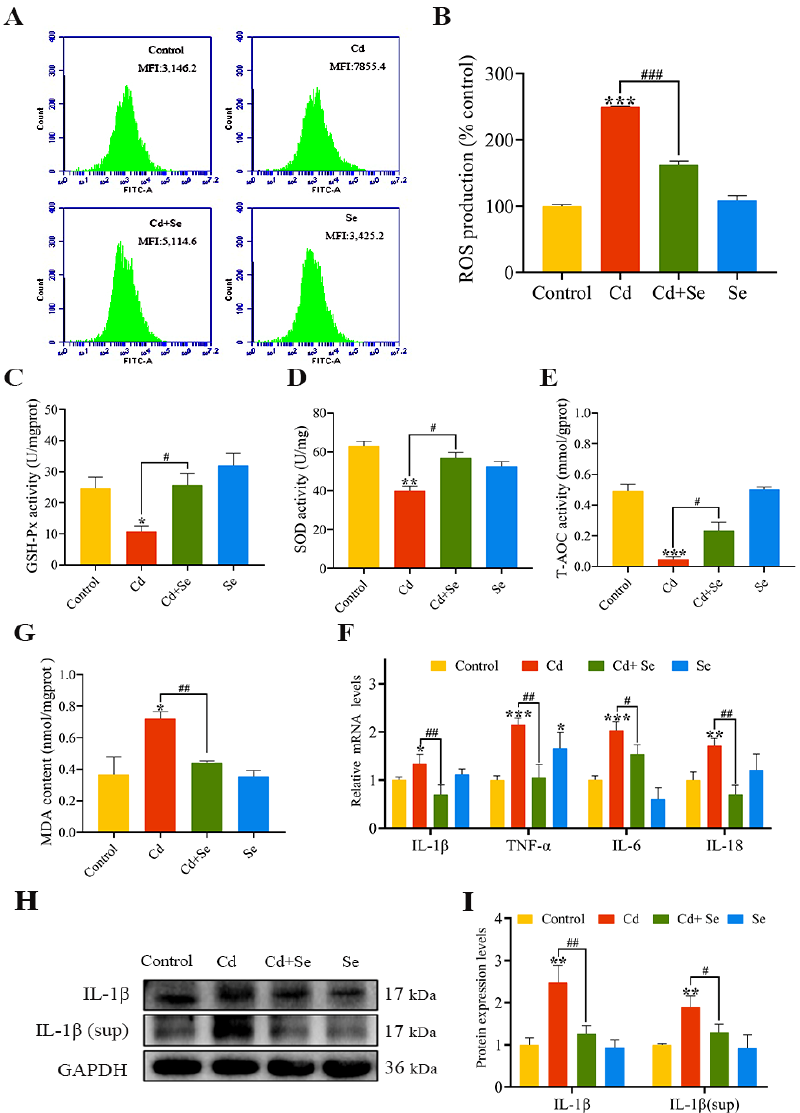
Figure 3 . Se protects against hepatocellular oxidative stress and inflammation caused by Cd. ( A , B ) Reactive oxygen species (ROS) level; ( C ) Glutathione peroxidase (GSH-Px) activity; ( D ) Superoxide dismutase (SOD) activity; ( E ) Total antioxidant capacity (T-AOC) activity; ( F ) Malondialdehyde (MDA) content; ( G ) The mRNA levels of IL-1 β , tumor necrosis factor (TNF)- α , IL-6 and IL-18; ( H ) Protein band graph; ( I ) The protein level of IL-1 β . (sup represents released extracellular protein of cells in culture supernatant) . The data are expressed as mean ± SD. “*” indicates a significant difference compared with control group (* p < 0.05, ** p < 0.01 and *** p < 0.001). “ # ” indicates a significant difference between Cd group ( # p < 0.05, ## p < 0.01 and ### p < 0.001).